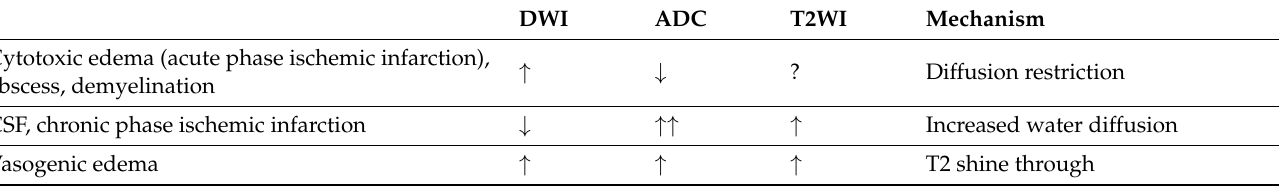
Table 1. Three types of MRI abnormalities in DWI, ADC, and T2WI sequences.